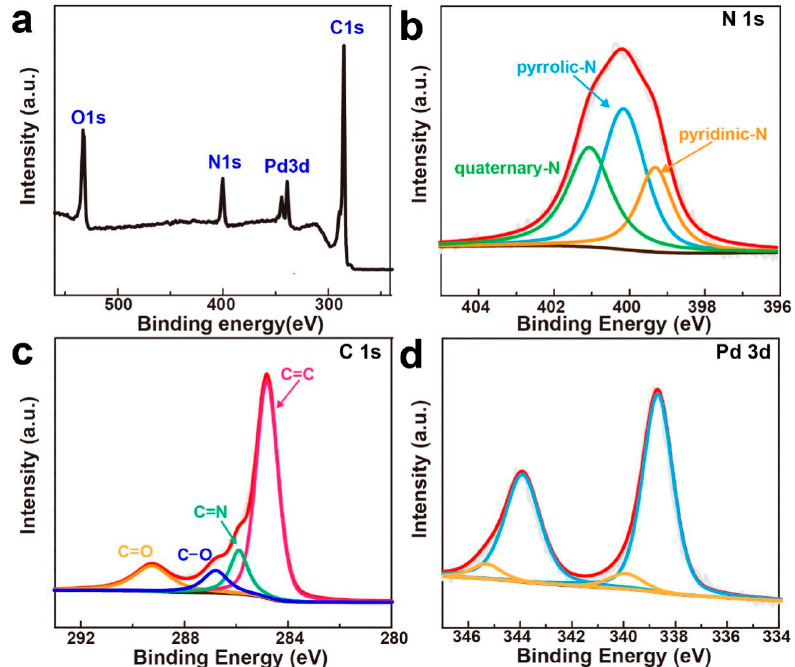
Figure 2. ( a ) The XPS survey spectrum and high-resolution XPS spectra of ( b ) N 1s, ( c ) C 1s, and ( d ) Pd 3d of Pd/NPC.